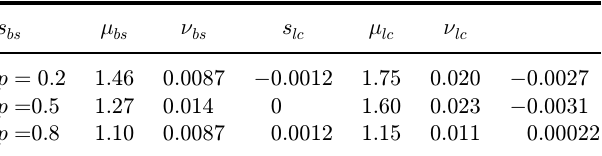
Table 4. Parameters of the distribution of erythrocytes in shape in a shear °ow with the shear rate of 448.0 s (cid:4) 1 , and level of light intensity at the isointensity line equal to 220 (in units of Fig. 6). The normalized light intensity at the isointensity line f ¼ 0 : 015. The number \p" stands for the proportion of non- 0 deformable red blood cells in a sample of blood. The experiment was performed with the blood of rat 2.